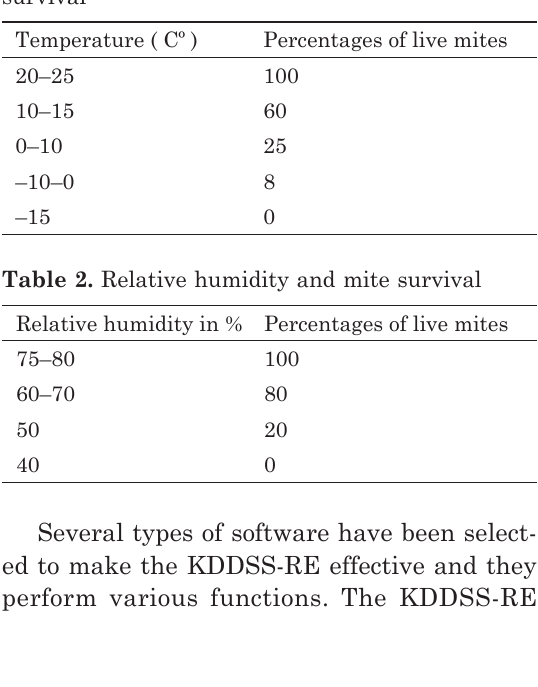
table 1. Influence of room temperature to house